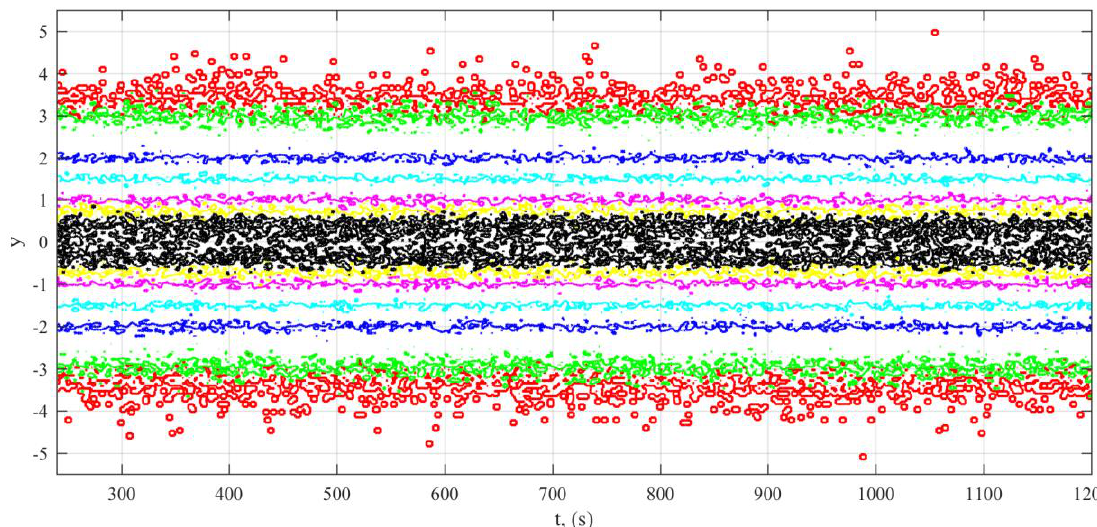
Figure 8. White noise after normalization by the level. Lines of equal probability for consecutive PDF for T = 1 s. This is lines of equal probability of the values of w(y): 0.000134 (red), 0.004432 (green), 0.053991 (blue), 0.1295 (cyan), 0.241971 (magenta), 0.3521 (yellow), 0.3867 (black). For the Gaussian distribution with the mean equal to 0 and variance equal to 1, this would be corresponding to the straight lines—also in accordance with values of y: ±4, ±3, ±2, ±1.5, ±1, ±0.5, ±0.25.